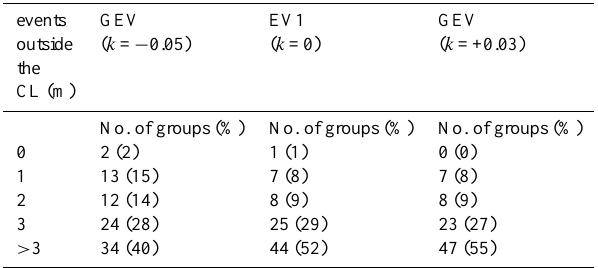
Table 4. Summary of events outside the confidence limits for 85 pooling groups.